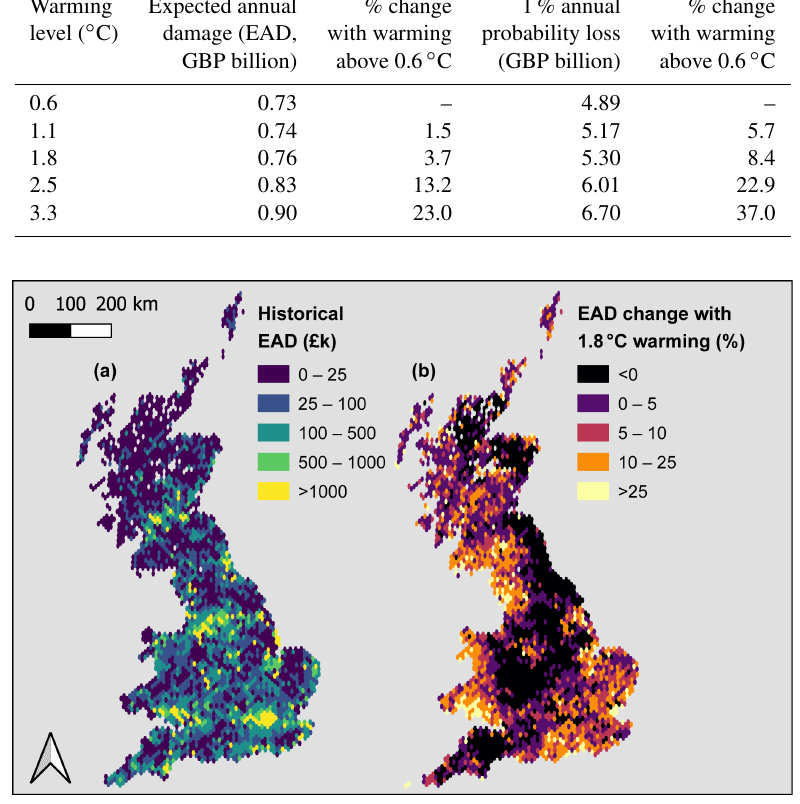
Figure 6. Spatial distribution of expected annual damage (EAD) due to flooding for historical conditions (0.6 ◦ C of warming) and percentage change between this and a warming level of 1.8 ◦ C, which approximately represents a world in which the Paris Agreement targets are